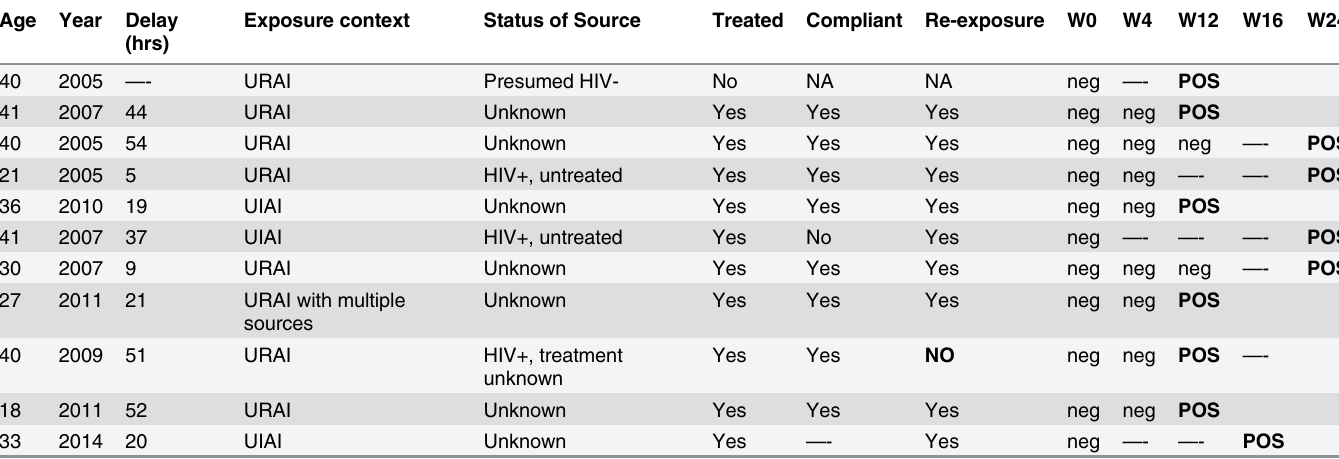
Table 5. Characteristics of seroconverted cases (N =